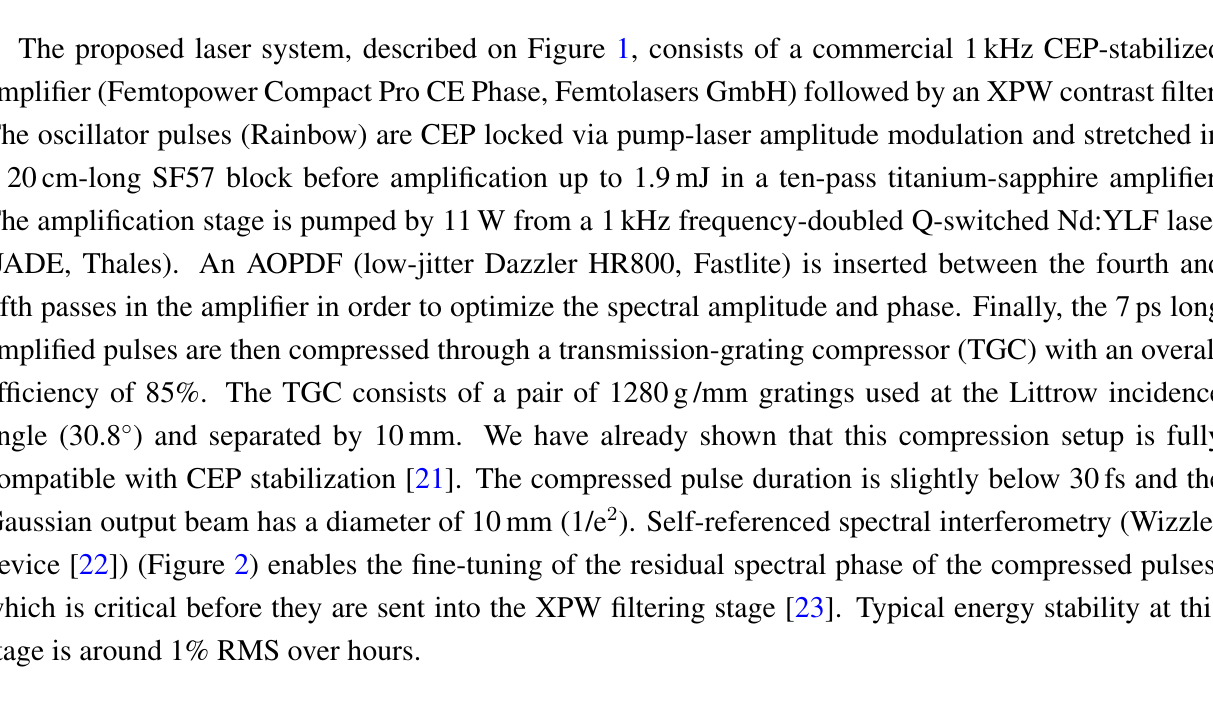
Figure 1. Experimental scheme of the 1 kHz CEP-stable CPA system and waveguide-XPW filter (TGC: Transmission Gratings